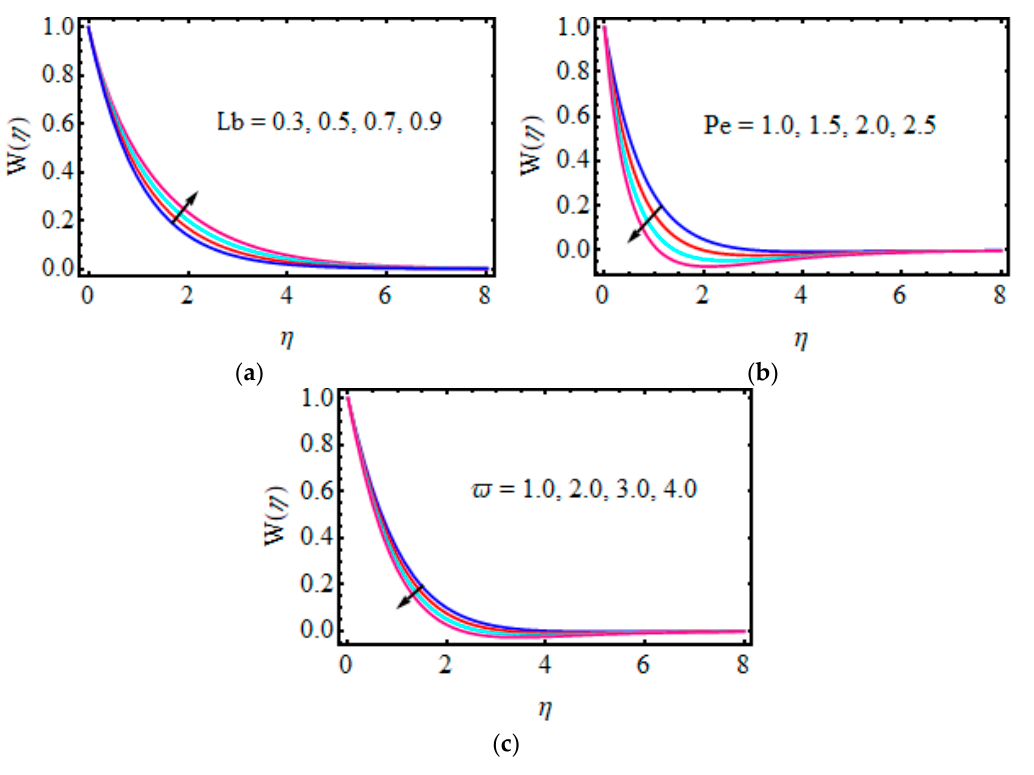
Figure 6. ( a – c ) The impact of the numerous variables of φ ( η ) : ( a ) Nb , ( b ) Nb and ( c ) Cr .